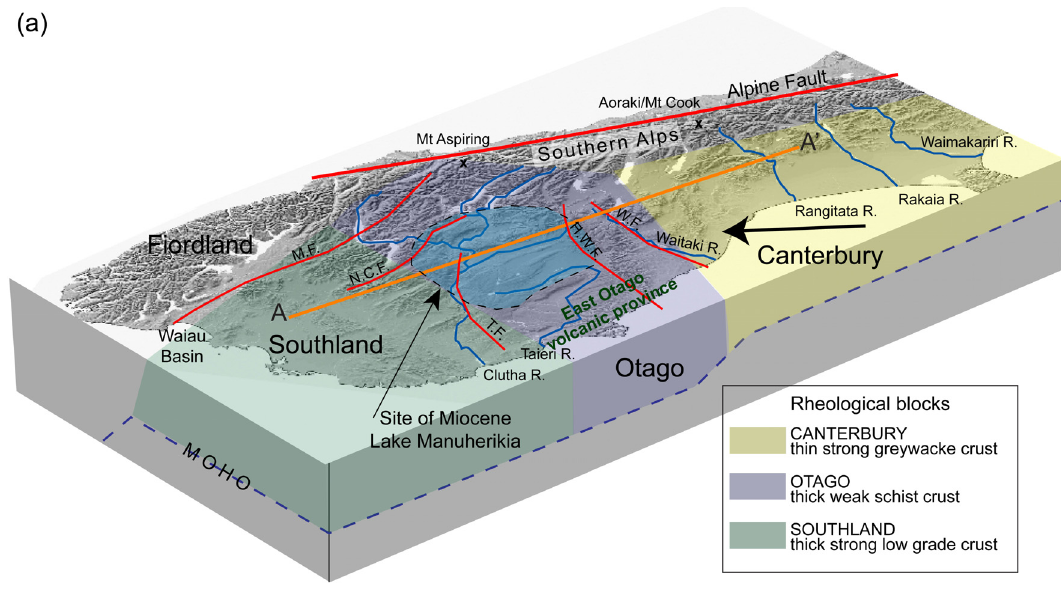
Figure 2. ( a ) Digital elevation model of the Southern South Island showing the current geography where the smooth ranges east of the Nevis-Cardrona Fault (N.C.F.) expose but retain the Waipounamu Erosion Surface [12]. The rheological blocks used in this study are shown as transparent overlays. The estimated extent of the Miocene Lake Manuherikia is shown by the light blue circle. Faults referred to in the text include the Moonlight Fault System (M.F.), the Tuapeka Fault (T.F.), Hawkdun/Waihemo Fault (H.W.F.) and the Waitaki Fault (W.F.). The location of the cross-section in ( b ) is shown by the orange line. ( b ) Conceptual model of how Lake Manuherikia and associated swamps formed as a result of strike slip deformation and a weak mid-crust beneath the Otago schist block showing the velocity distribution through the crust with the resultant strain and vertical displacements. Single headed arrows represent material movement. Double headed arrows represent relative movement between blocks with contraction = arrows facing and stretching = arrows facing in opposite directions. The crust and mantle are coupled where there is a strong mid-crust but are uncoupled beneath the weak lower crust. BDT: brittle ductile